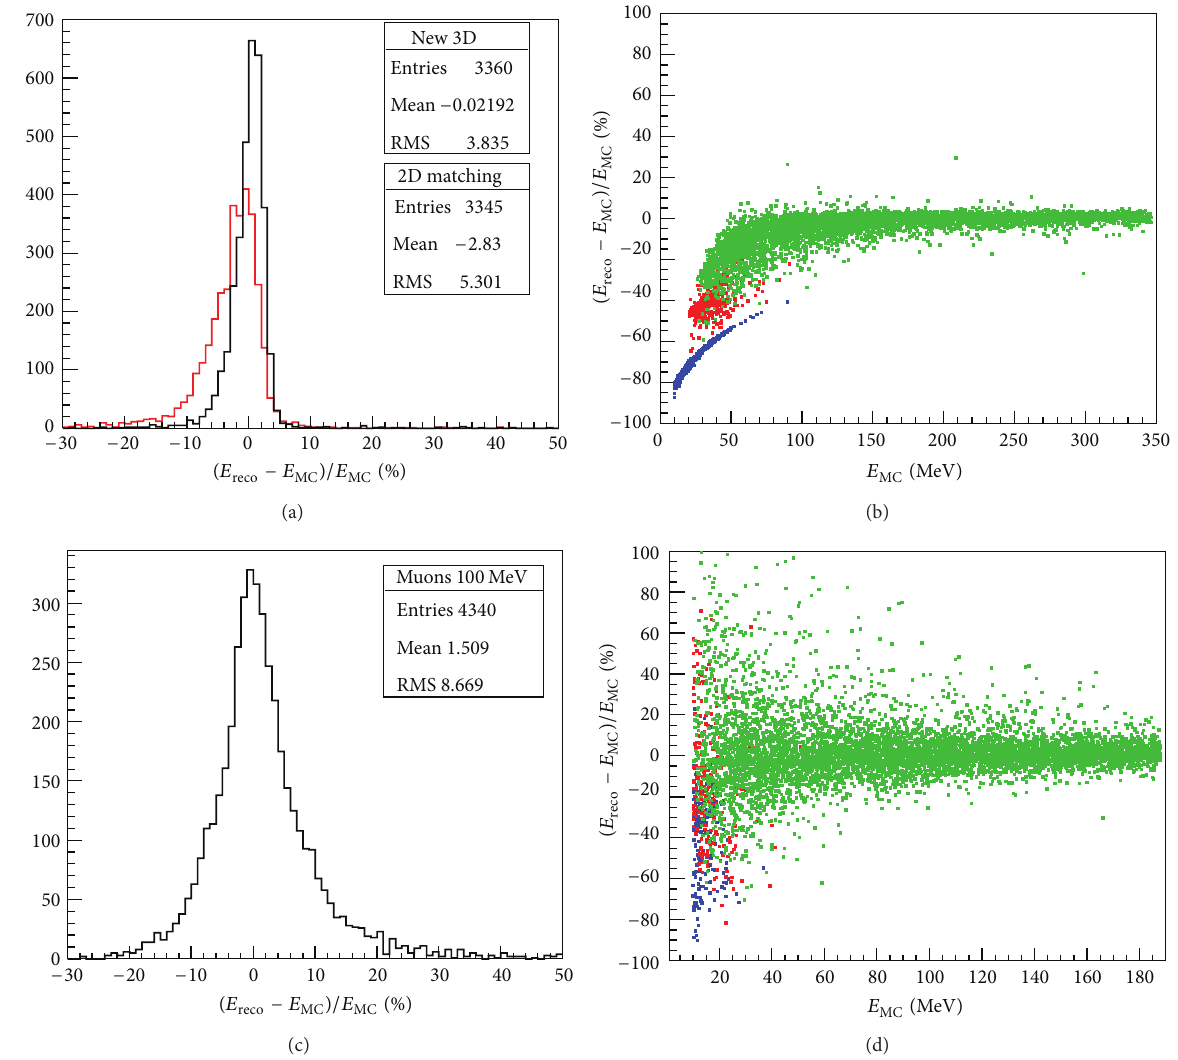
Figure 12: Calorimetric reconstruction: (a) protons, initial 𝐸 𝑘 = 232 MeV, range 30 cm; the new 3D reconstruction-black curve, 2D hit matching-red curve; (b) protons, initial 𝐸 𝑘 : (10–350)MeV, range up to 60cm; dots color: 1, 2 hits in the track-blue, 3 hits in the track-red, 4 and more hits in the track-green; (c) muons, initial 𝐸 𝑘 = 100 MeV, range 30 cm; (d) muons, initial 𝐸 𝑘 : (10–185)MeV, range up to 60cm; color is the same as in